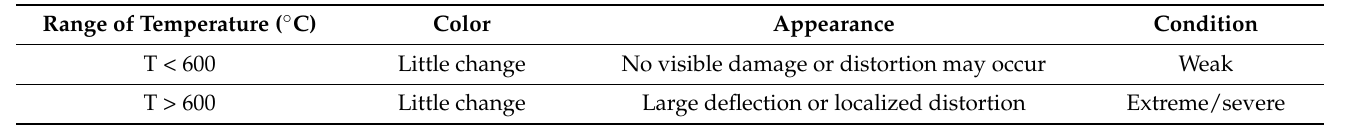
Table 2. Color changes in steel at specified range of temperature,